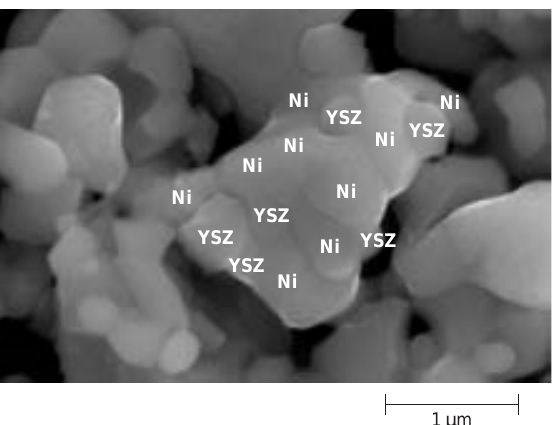
Performance comparison of SOFC anode fabricated by MCB treated NiO-YSZ composite particles to that by the conventional powder